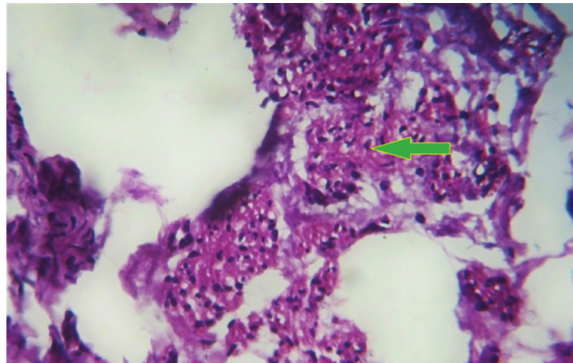
Figure 2: Arrow shows rudimentary dartos